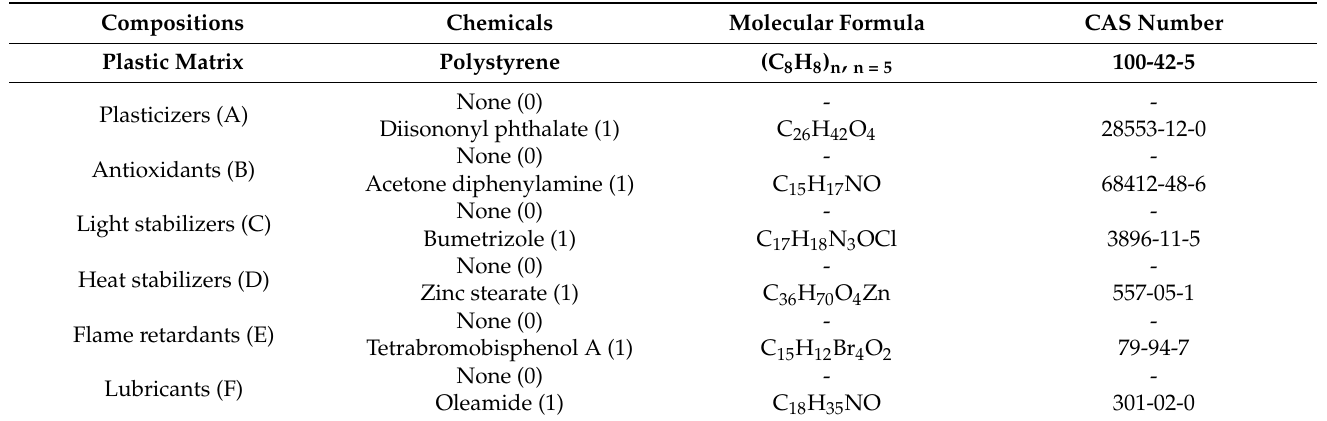
Table 2. Setting the proportioning system for plastic additives.